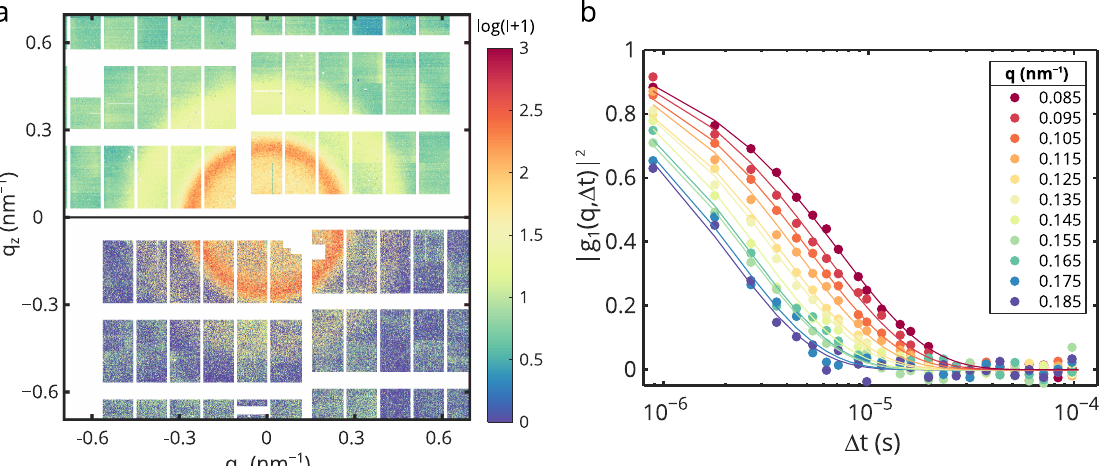
Figure 10. ( a ) Scattering pattern measured with AGIPD at SPB/SFX averaged over 500 trains (Top) and single-shot speckle pattern (Bottom). White parts are masked pixels and blind regions between the AGIPD modules. The intensity scale is given in analog-to-digital unit (ADU) values, one photon corresponds to 65 ADU. ( b ) Intermediate scattering functions measured from diffusing silica nanoparticles in water from as single train of 120 X-ray pulses. Figures adapted from